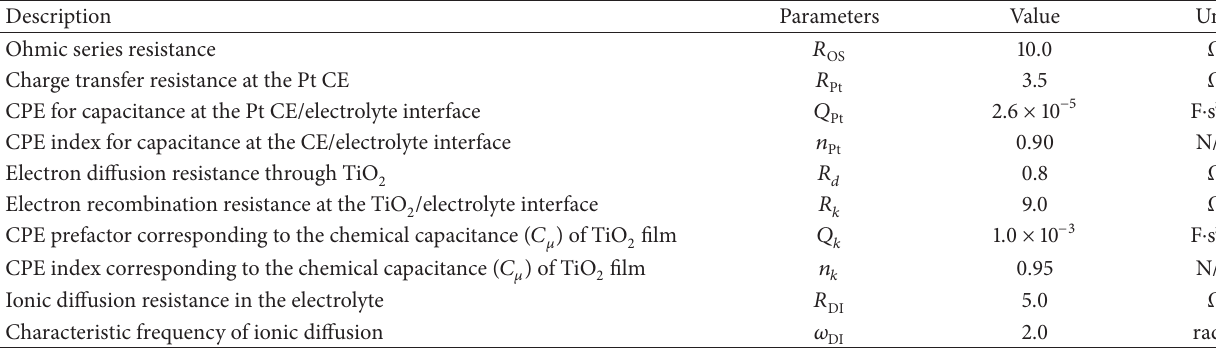
Table 2: Parameters used to calculate EIS spectra of